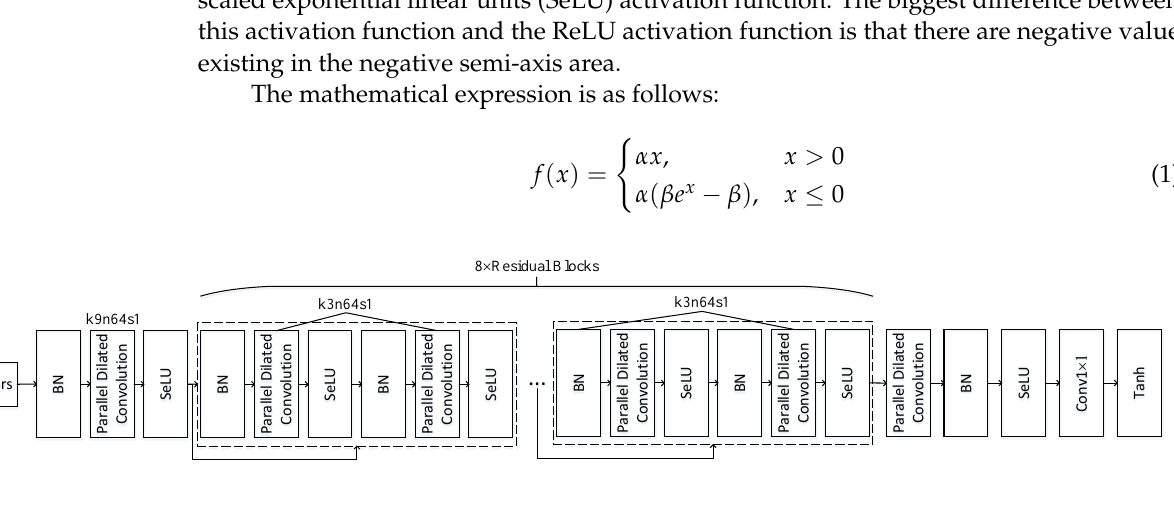
Figure 2. Network structure of the generator. k, n, and s indicate kernel size, number of feature maps, and stride,